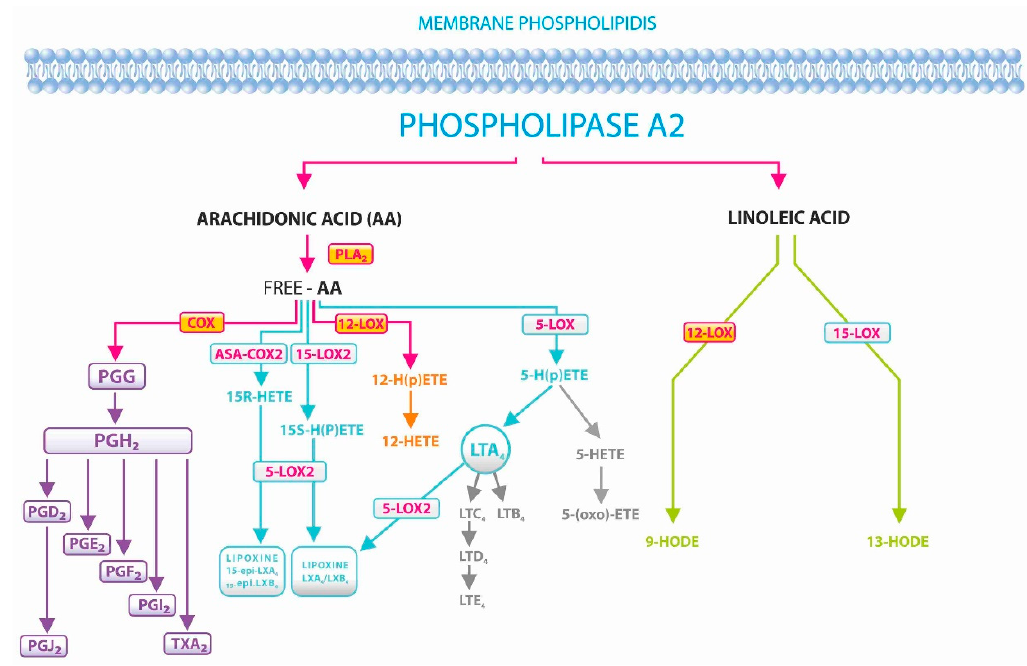
Figure 1. Metabolic pathways of arachidonic and linoleic acids in humans. Arachidonic and linoleic acid